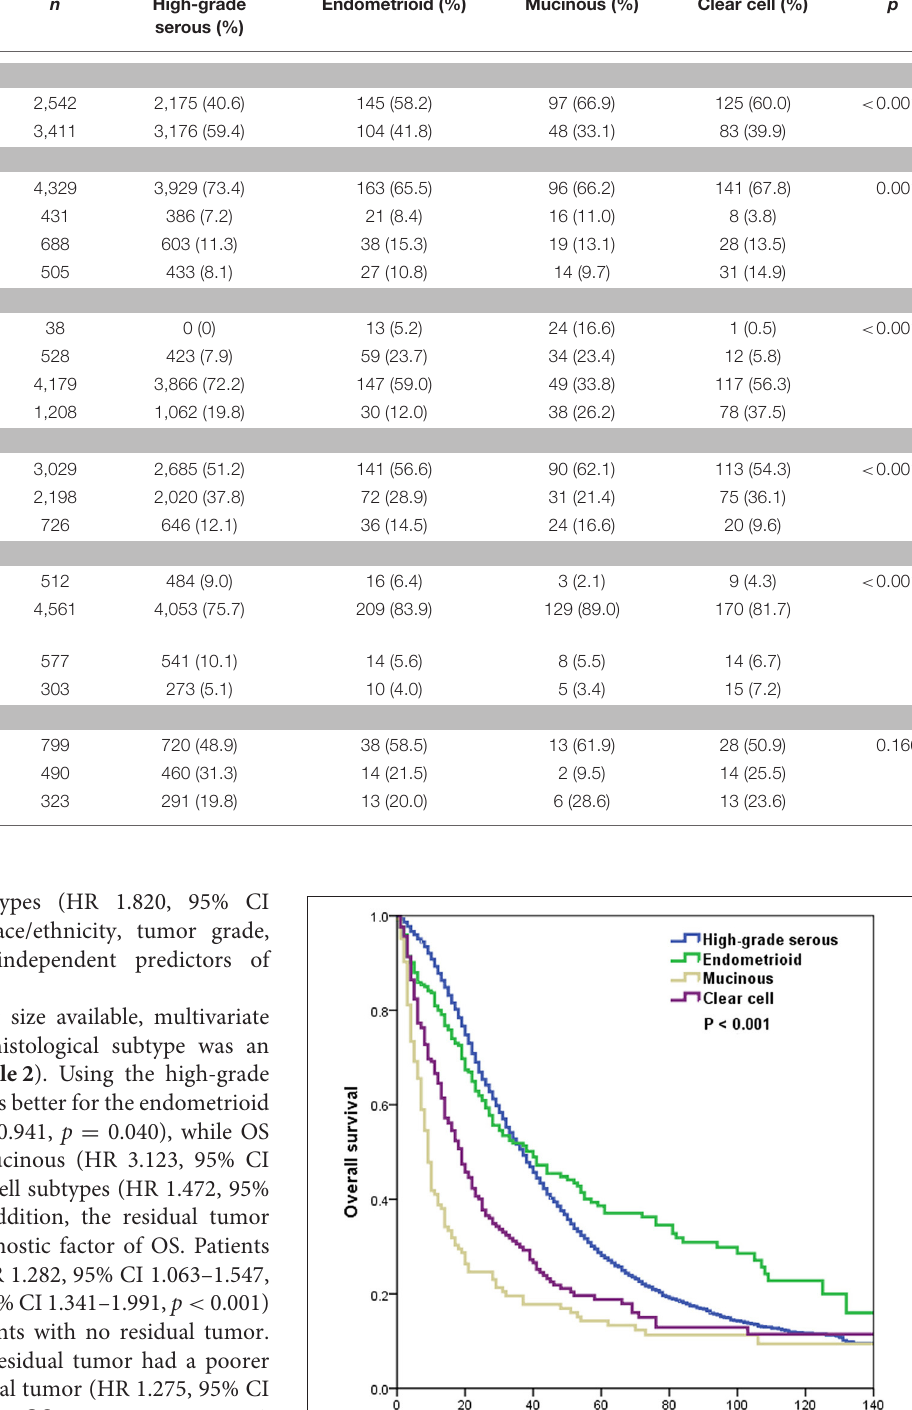
TABLE 1 | Baseline characteristics of epithelial ovarian cancer patients by histologic subtypes. Variables